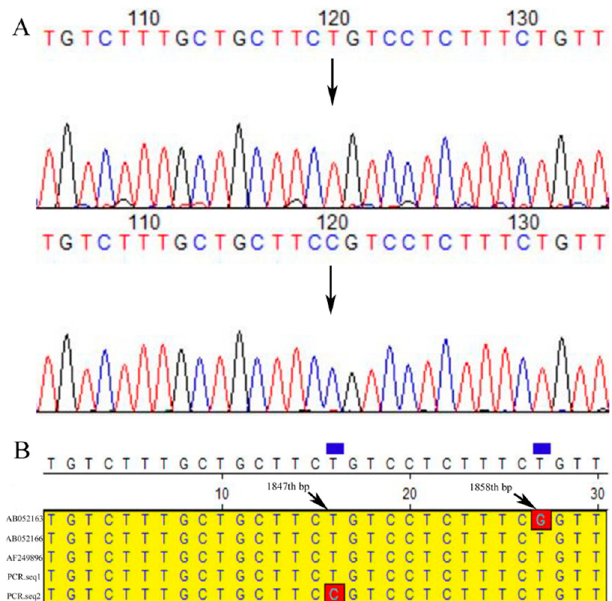
Figure 2. The 4th pair of primer products were directly sequenced and aligned in the NCBI database. ( A ) The α -LA gene polymorphism locus (black arrow mark) and its nearby sequences in Chinese Holstein cows. ( B ) The sequence near the LA gene polymorphism site of Chinese Holstein cows aligned with the three bovine sequences (AF249896 (Bos Taurus), AB052166 (Holstein) and AB052163 (Jersey)) in the NCBI library. One locus (red frame marker, 1847th) was the polymorphism of α -LA gene in Chinese Holstein cows. Another site (red frame marker, 1858th) was the differential locus of α -LA gene between Jersey and Holstein.